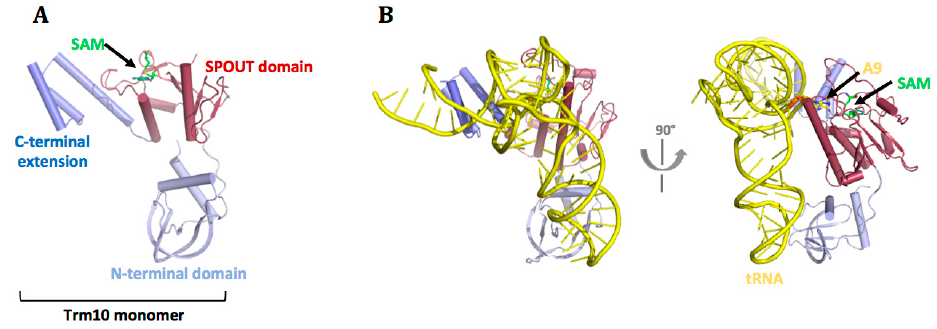
Figure 6. Structural data of Trm10. ( A ) Full ‐ length Trm10 from Sulfolobus acidocaldarius (PDB 5A7Y). Residues 182–202 are not modelled. (B) Docking from [84] of Escherichia coli initiator tRNA